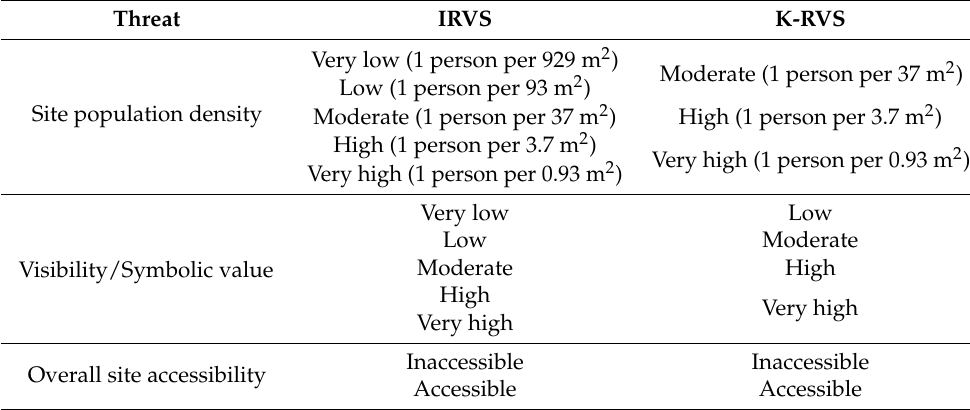
Table 5. Comparison table for threat between IRVS and